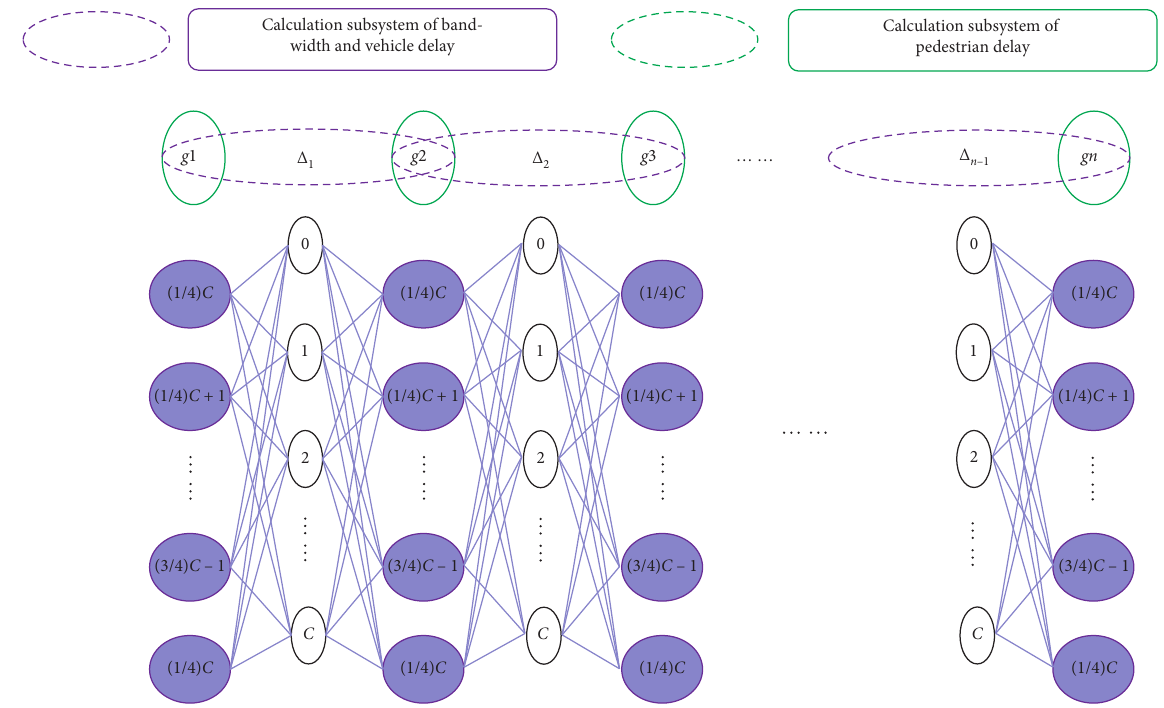
Figure 8: Subsystem of calculation in each layer.